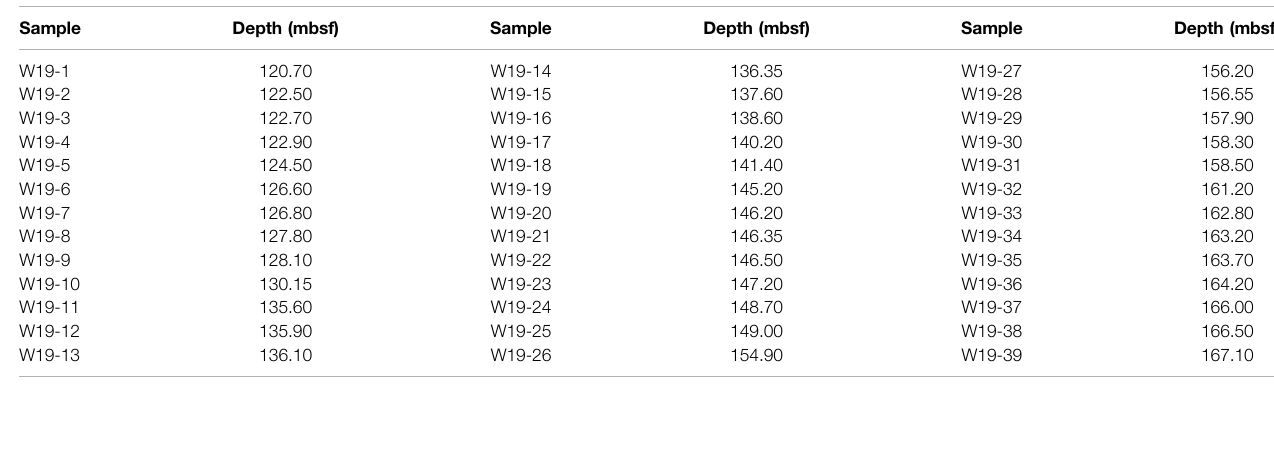
TABLE 1 | The sample list of Site W19.